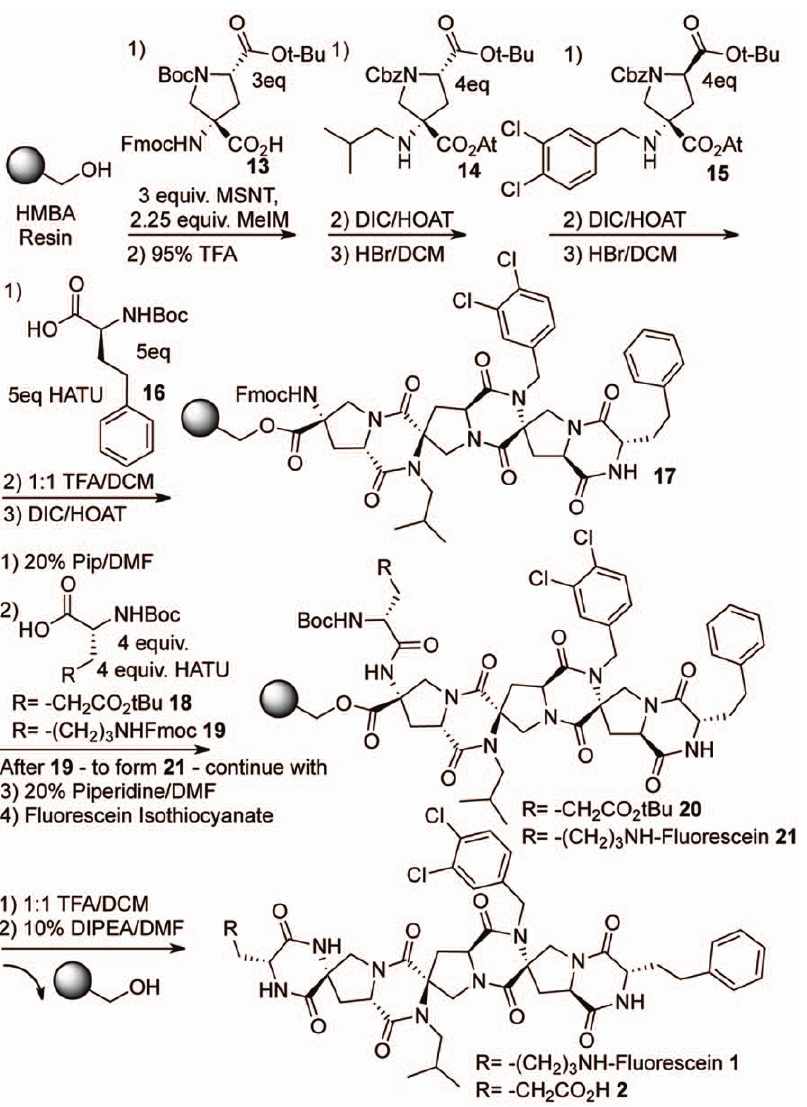
Figure 2. The solid-phase synthesis of spiroligomers 1 and 2 using the HMBA resin. Building blocks were successively coupled using either esterification conditions for residue 13 or conditions previously developed to achieve hindered active esters 14 or 15 [16]. Further derivatization of the oligomers followed by cyclization of the terminal DKP released spiroligomers 1 and 2 from the solid support [16].